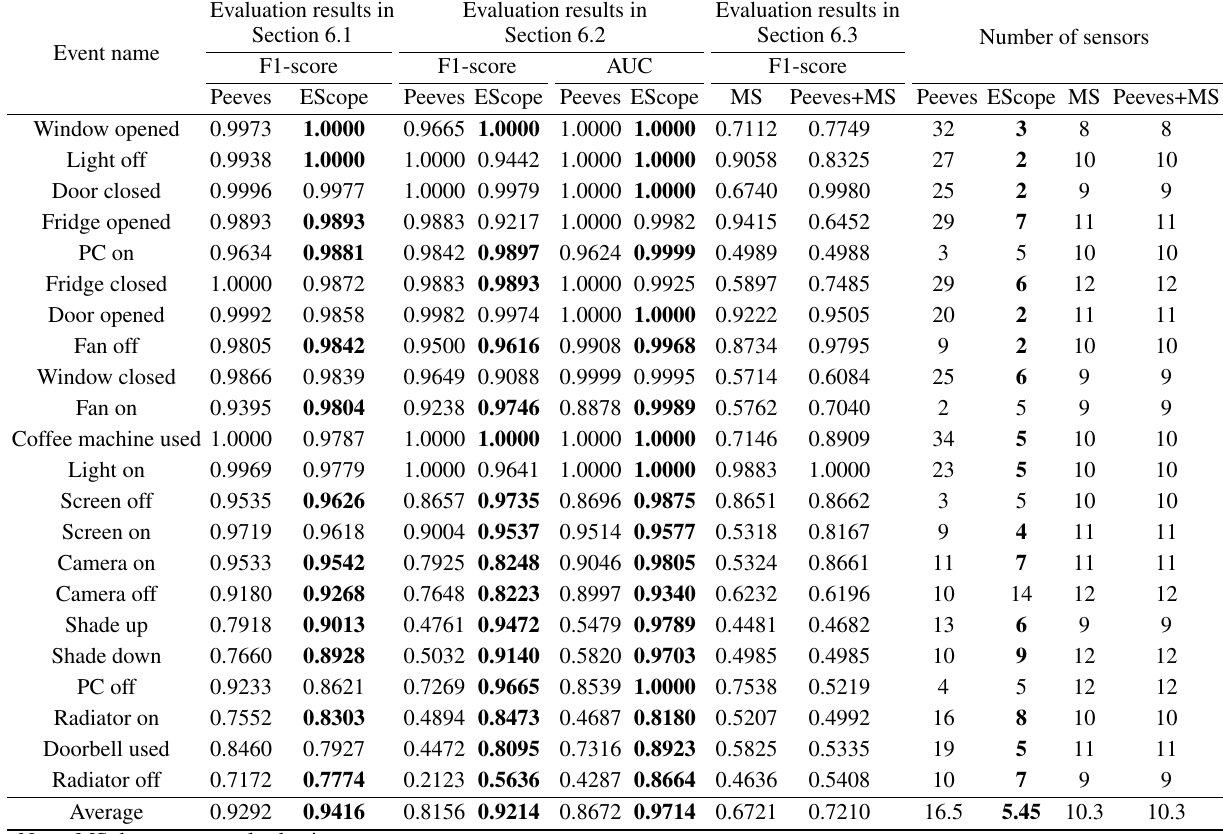
Table 3 Performance and number of selected sensors of different